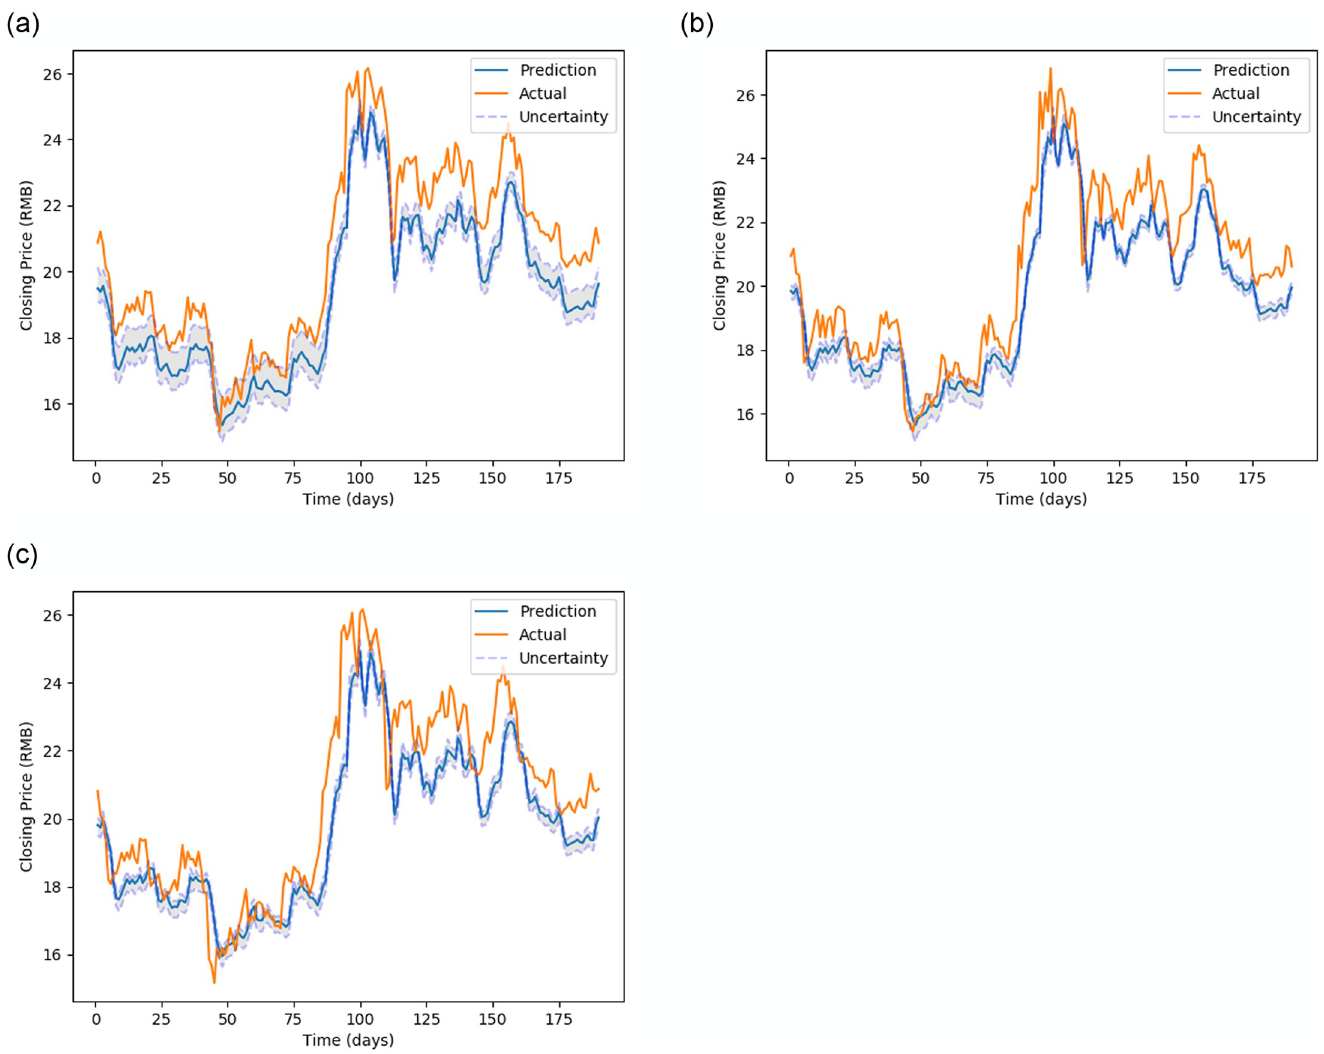
Fig 6. Prediction and uncertainty (shaded region) for test data of stock